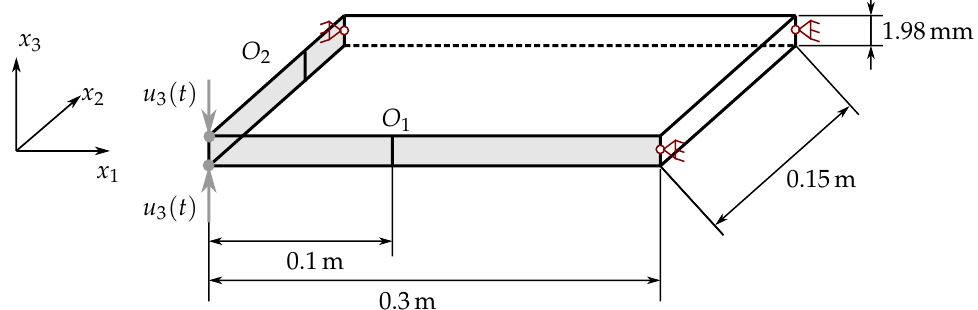
Figure 6. Numerical 3D model for the computation of displacement fields including the bound- ary